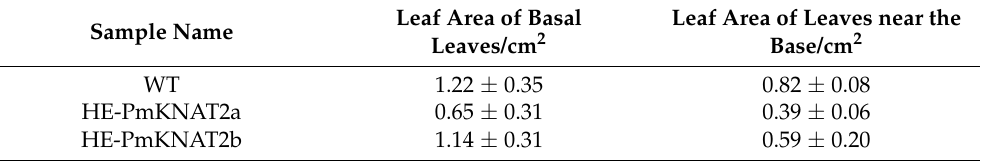
Table 3. HE-PmKNAT2 Arabidopsis leaf area compared with wild type.